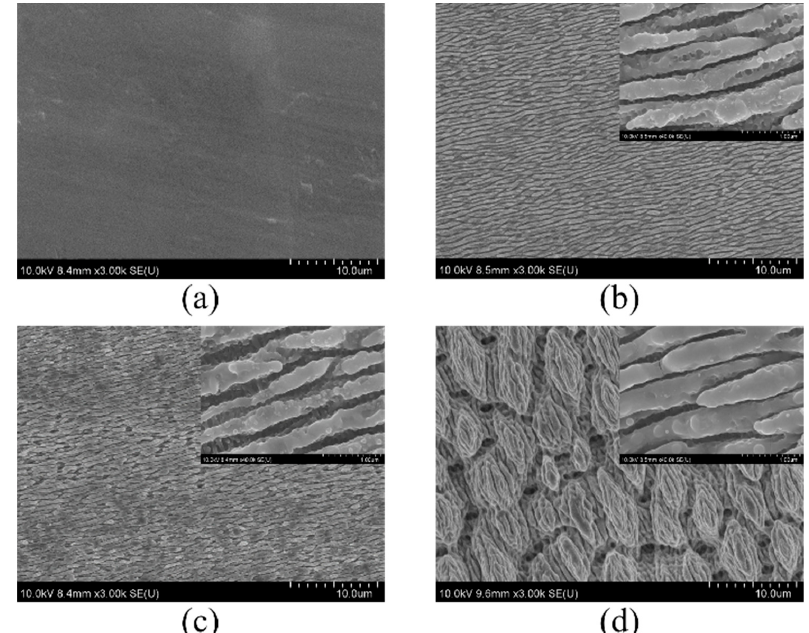
Figure 1. Morphological evolution of Ti6Al4V surface after irradiation with progressively laser scan times: ( a ) untreated; ( b ) 5 cycles; ( c ) 20 cycles; ( d ) 30 cycles. Nanomaterials 2019 , 9 , x FOR PEER REVIEW